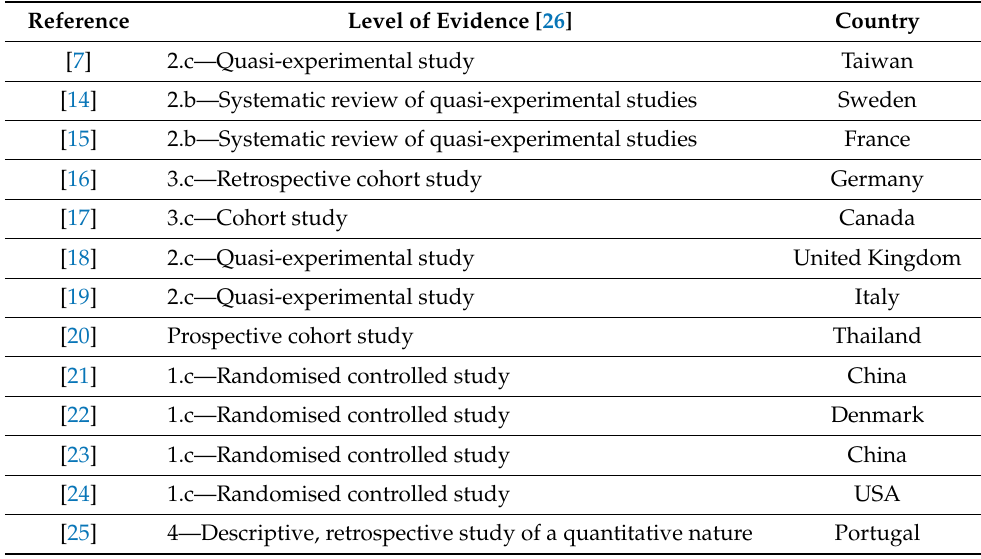
Table 2. Classification of included articles by level of evidence and country of origin. Lisbon, 2020.